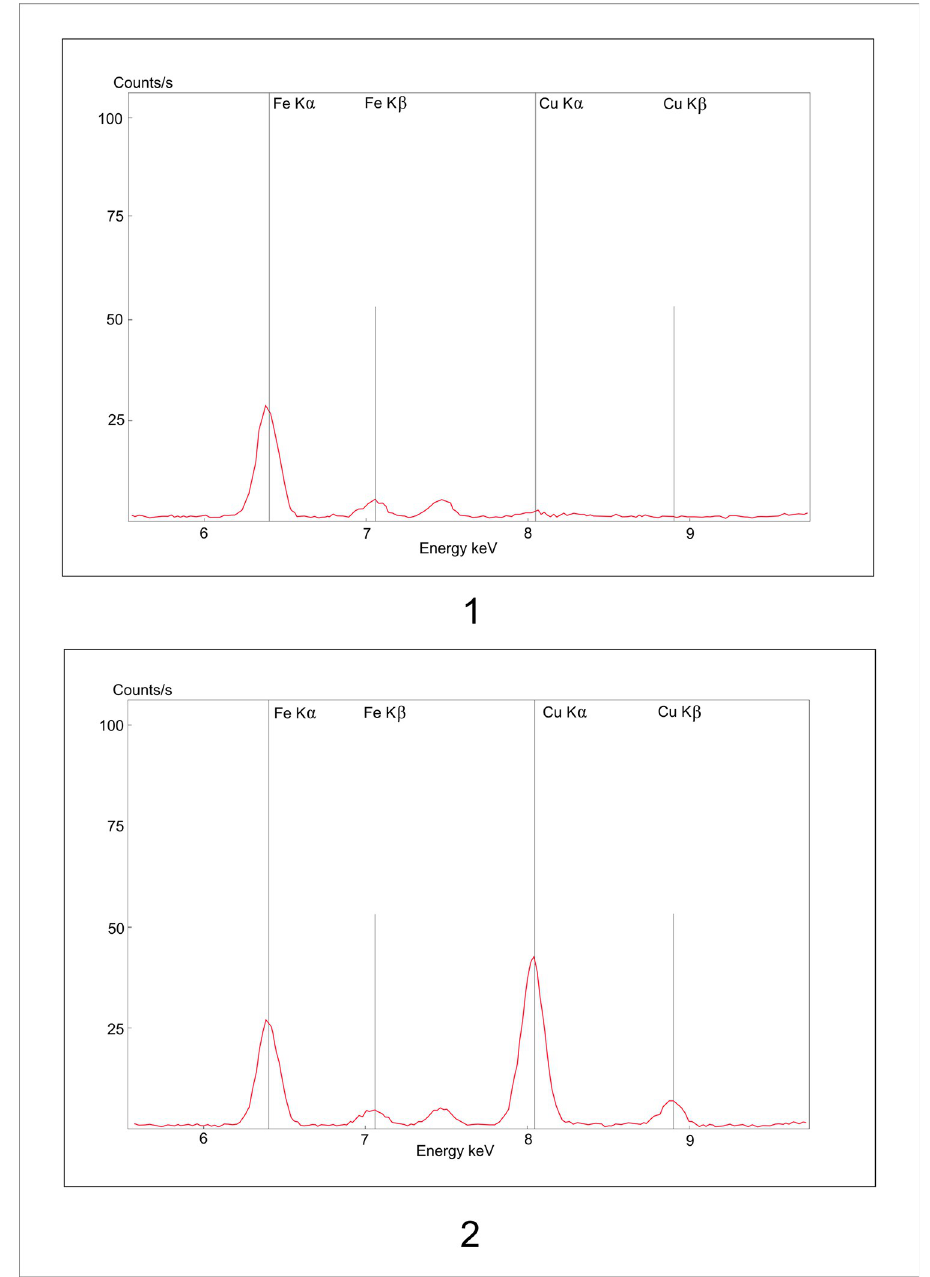
Fig 6. Experimental XRF measurement of the unworked (1) and worked (2) surface by the tool made of copper. The picture (2) shows a significant increase of the presence of the copper on the surface-red line (author: M. Cihla).